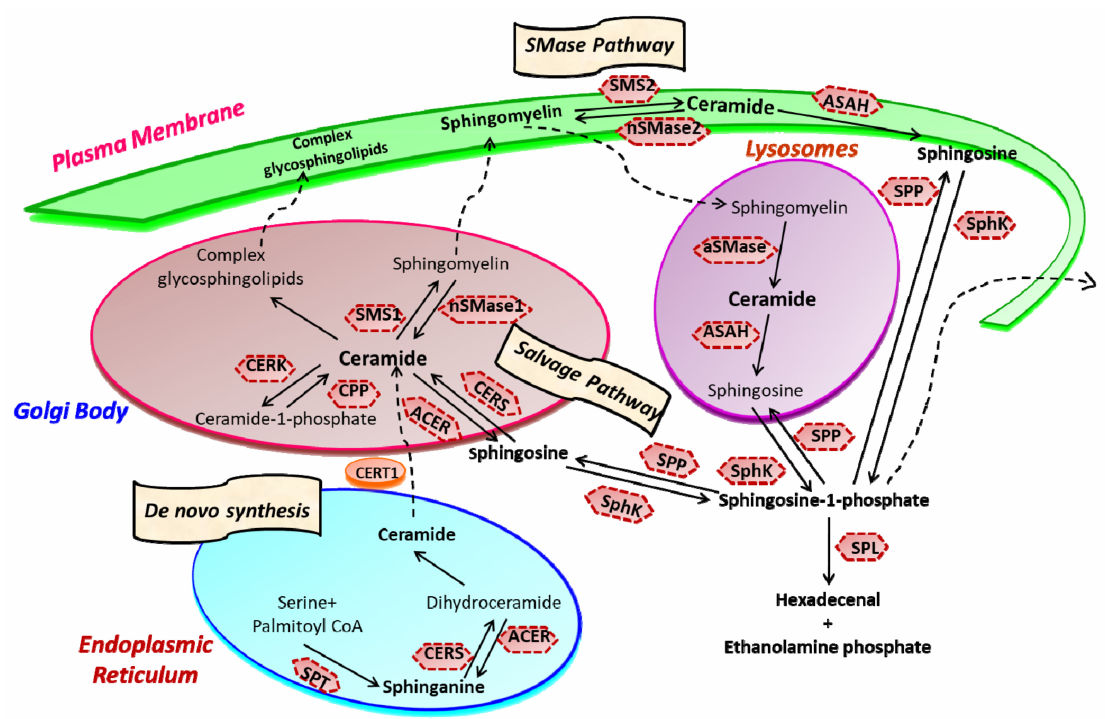
Figure 1. Sphingolipid metabolism and compartmentalization. Three significant mechanisms for ceramide generation are illustrated. Ceramide is synthesized via s “de novo pathway” in the ER from where it is transported to the Golgi bodies through CERT and serves as a substrate for the synthesis of complex glycosphingolipids (GLSL) and sphingomyelin (SM). GLSL and SM are transported to the plasma membrane through vesicular transport. In another mechanism; ceramide can be generated by the action of neutral or acidic SMases (“SMase pathway”) in the plasma membrane. Finally, in the “salvage pathway”, ceramide is synthesized from sphingosine released from the lysosome by the catalytic action of CERS. (SPT, Serine palmitoyltransferase; CERS, Ceramide synthase; CERK, Ceramide kinase; CPP, Ceramide-1-phosphate phosphatase; SMS, Sphingomyelin synthase; SMase, Sphingomyelinase; ACER, ceramidase in Golgi bodies; ASAH, ceramidase in lysosomes; SK, sphingosine kinase; SPP, Sphingosine-1-phosphate phosphatase; SPL, S1P lyase) (Figure is adapted from reference